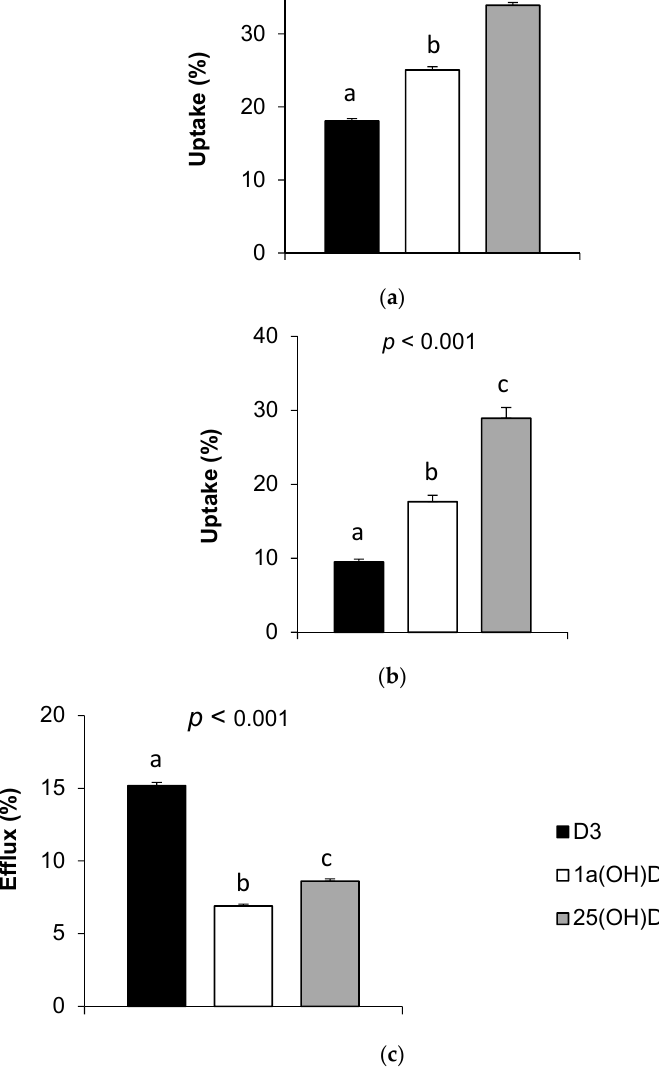
Figure 3. Uptake and efflux of vitamin D forms by Caco-2 cells. ( a ) Uptake of D 3 , 1 α (OH)D 3 , and 25(OH)D 3 at high concentrations, i.e., >5 µ M. D 3 , 1 α (OH)D 3 and 25 (OH)D 3 apical concentrations at t0 were 9.54, 11.17, and 7.22 µ M respectively ( n = 6); ( b ) Uptake of D 3 , 1 α (OH)D 3 , and 25(OH)D 3 at low concentrations, i.e., <1 µ M. D 3 , 1 α (OH)D 3 , and 25 (OH)D 3 apical concentrations at t0 were 0.20, 0.37, and 0.10 µ M, respectively ( n = 3); ( c ) Efflux of D 3 , 1 α (OH)D 3 , and 25(OH)D 3. D 3 , 1 α (OH)D 3 , and 25(OH)D 3 cellular concentrations at t0 were 1.12, 3.77, and 1.89 µ M, respectively ( n = 3). Bars with unlike letters were significantly different for a given